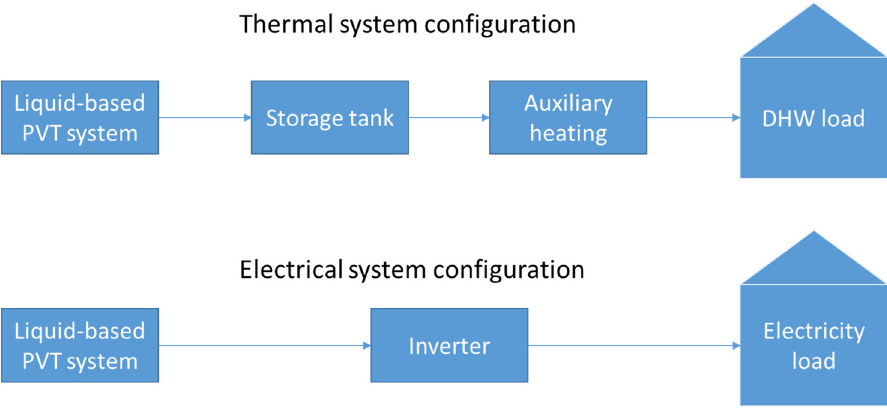
Figure 5. Thermal and electrical system configurations.